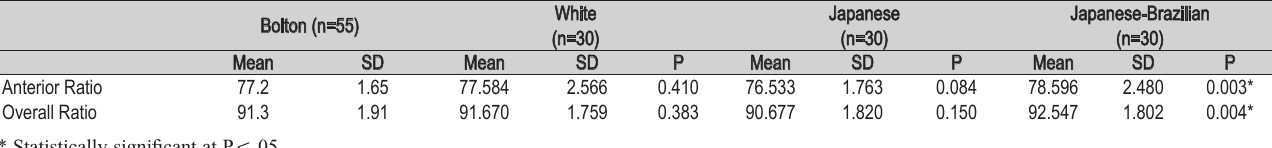
* Statistically significant at